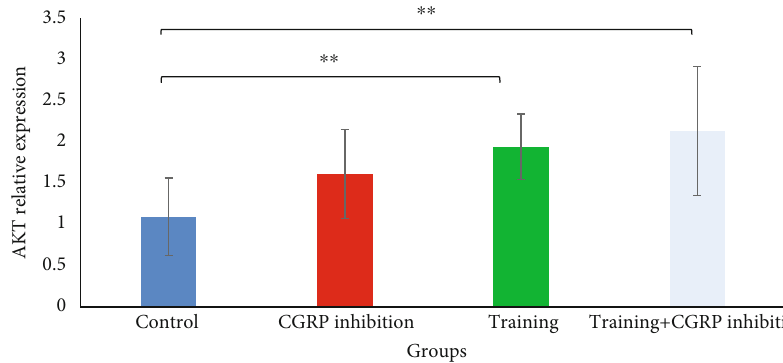
Figure 2: AKT gene expression comparison in hippocampus between groups. ∗∗ Signi fi cant di ff erence compared to control group ( P < 0 : 05